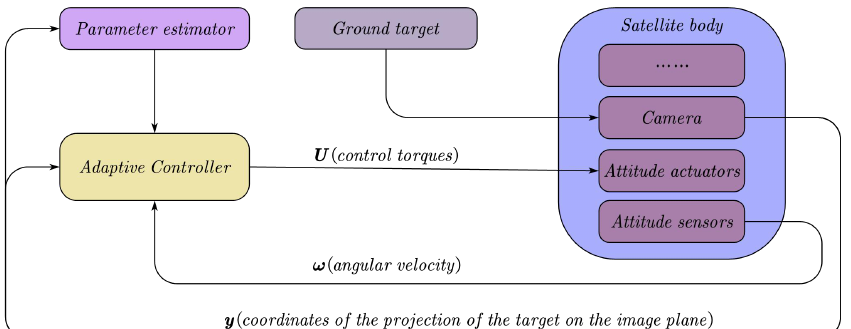
Figure 4. The framework of the image-based staring